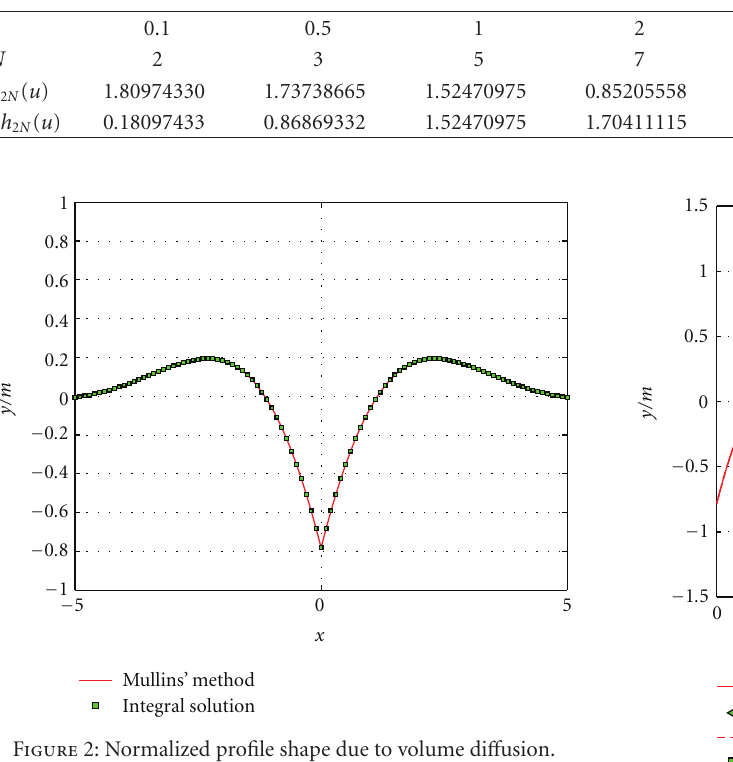
Figure 2: Normalized profile shape due to volume di ff usion.